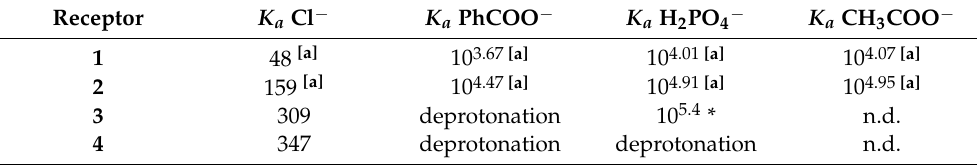
6 + 0.5% H 2 O at 298K.